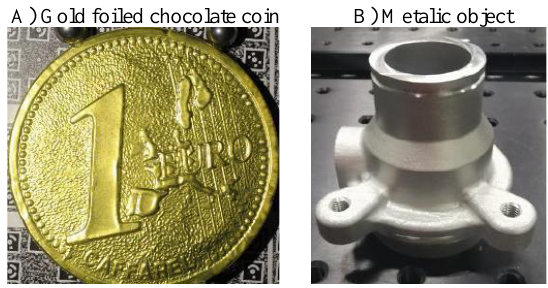
Figure 1. Examples of non-collaborative